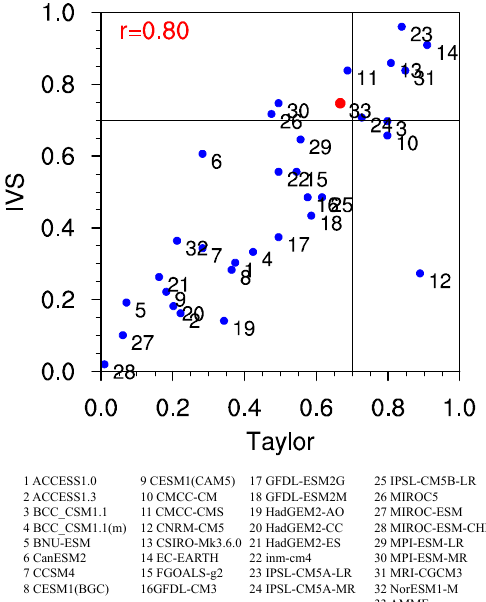
Figure 5. Scatter diagrams of MR based on Taylor diagrams and IVS for extreme rainfall. The numbers of 1–32 represent 32 individual CMIP5 climate models (Table 1) and 33 denotes the CMIP5 multi-model ensemble mean.